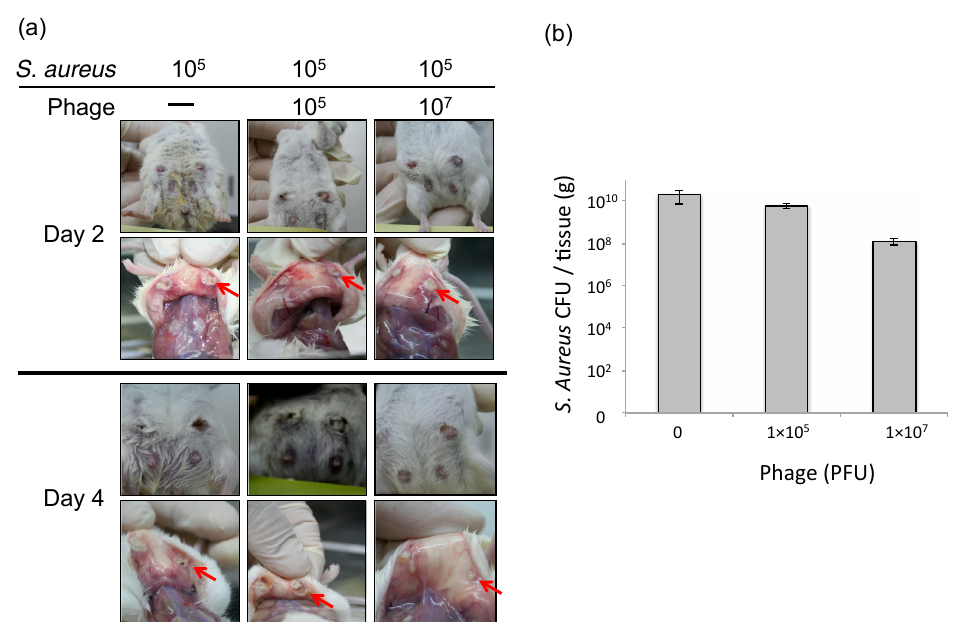
Figure 1. Therapeutic efficacy of Φ SA012 in a mouse model of S. aureus mastitis. ( a ) Photographs of the mouse mastitis model after administration of SA003 (10 5 CFU, n = 5) and phage treatment (10 5 PFU (MOI = 1, n = 7) and 10 7 PFU (MOI = 100, n = 6)). Arrows indicates abscesses. ( b ) S. aureus CFUs in the mammary glands on day 2 after challenge. Bars indicate standard errors of the means. There was no statistically significant difference.